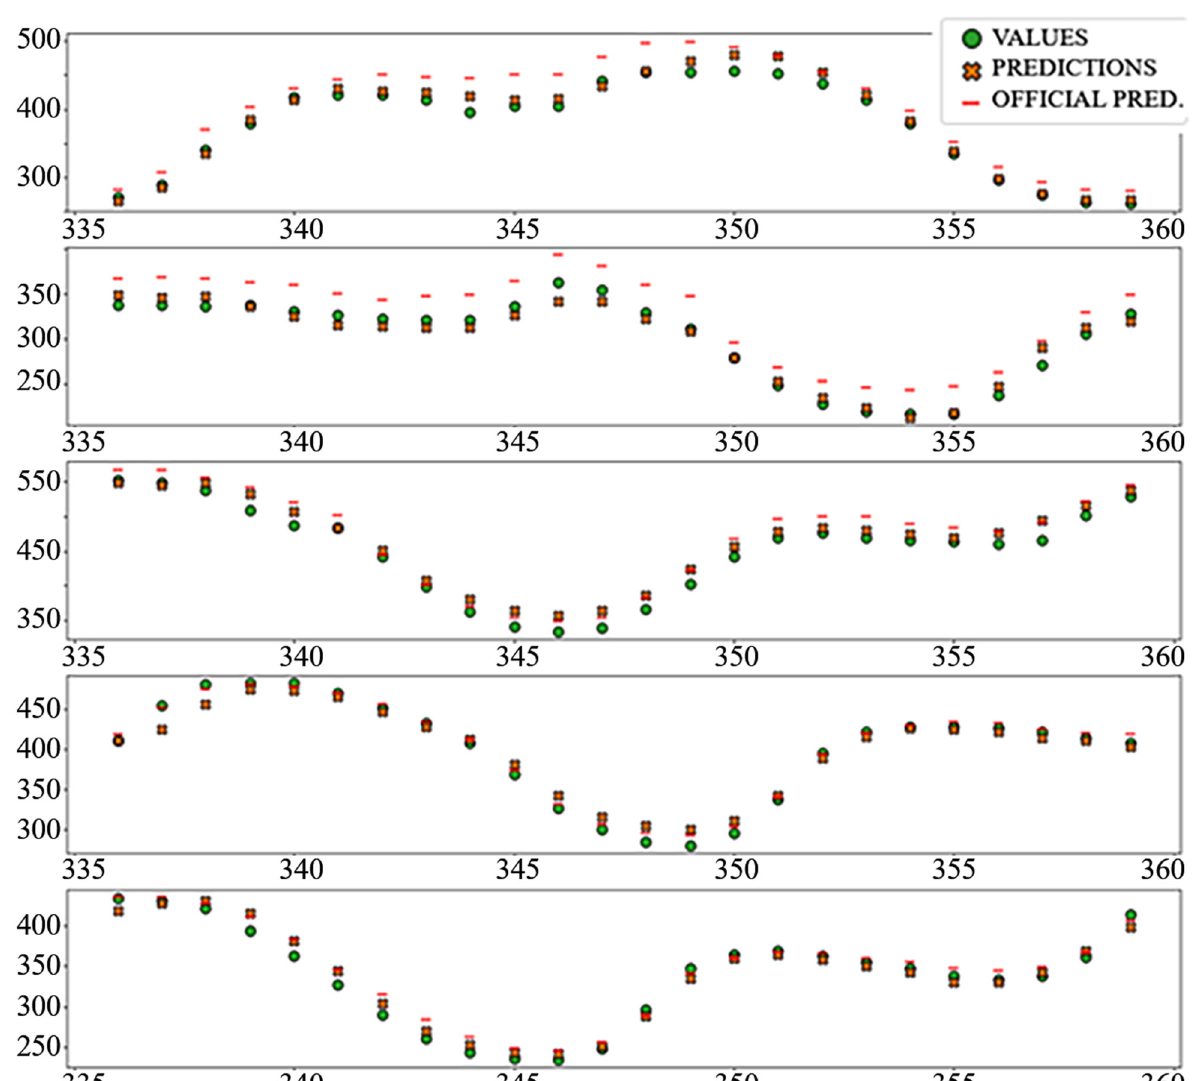
Figure 17. Load prediction: “TCN_Dense” model.